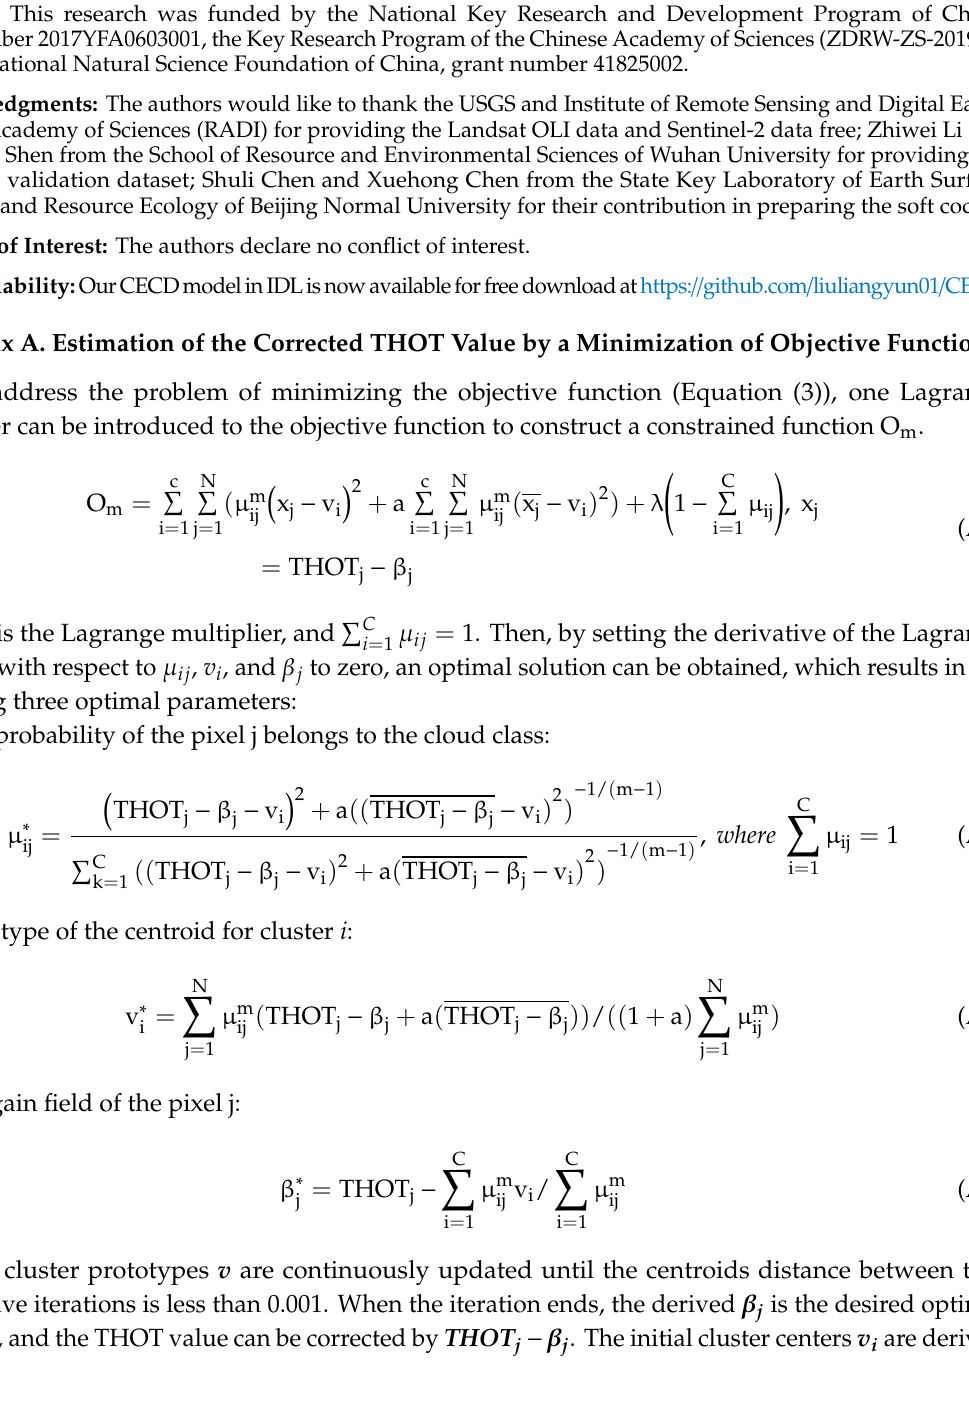
Table S1: Details of the 14 Landsat-8 scenes selected from the Landsat 8 Cloud Cover Assessment